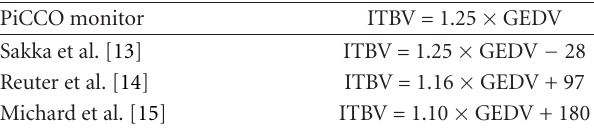
Table 1: Di ff erent formulas for the calculations of ITBV reported in the current literature.